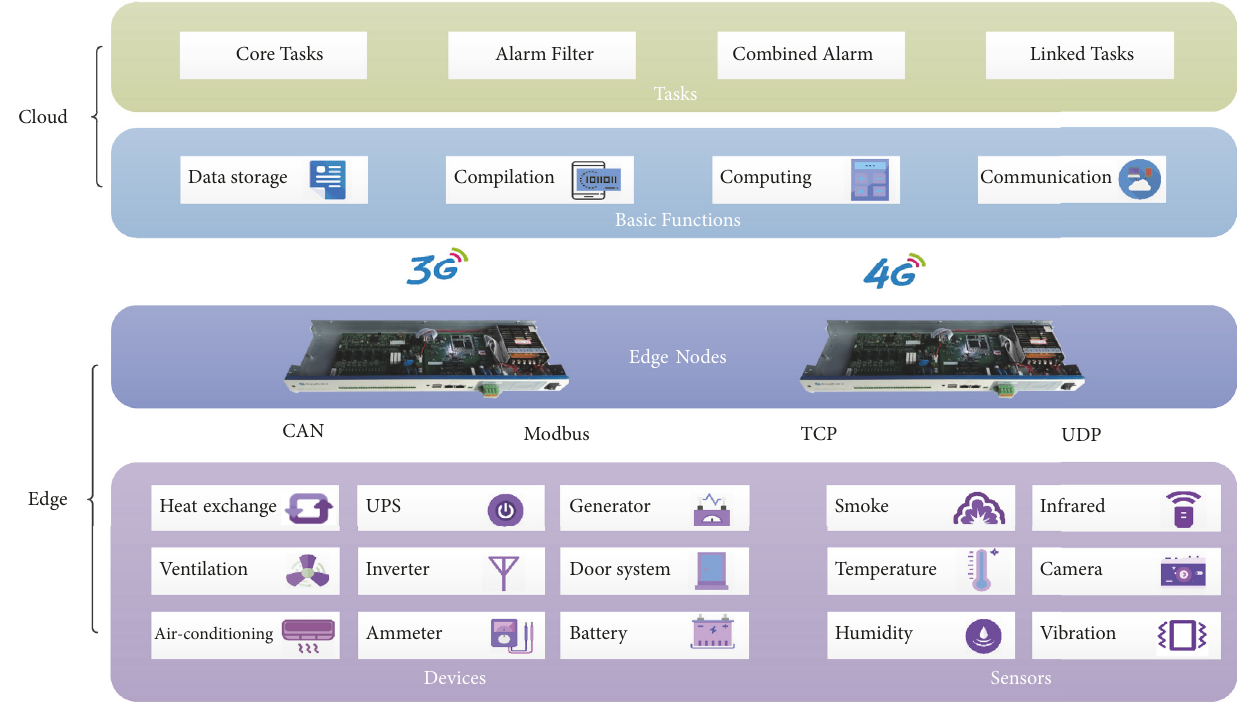
Figure 1: The BSIS architecture. BSIS mainly consists of the edge, the network, and the cloud. The edge and cloud are connected by a mixed 3G and 4G network. The cloud part offers basic functions that support many tasks. The ePLCs operate as the edge node and can either collect data from the sensors directly or from the controllers using different communication protocols.